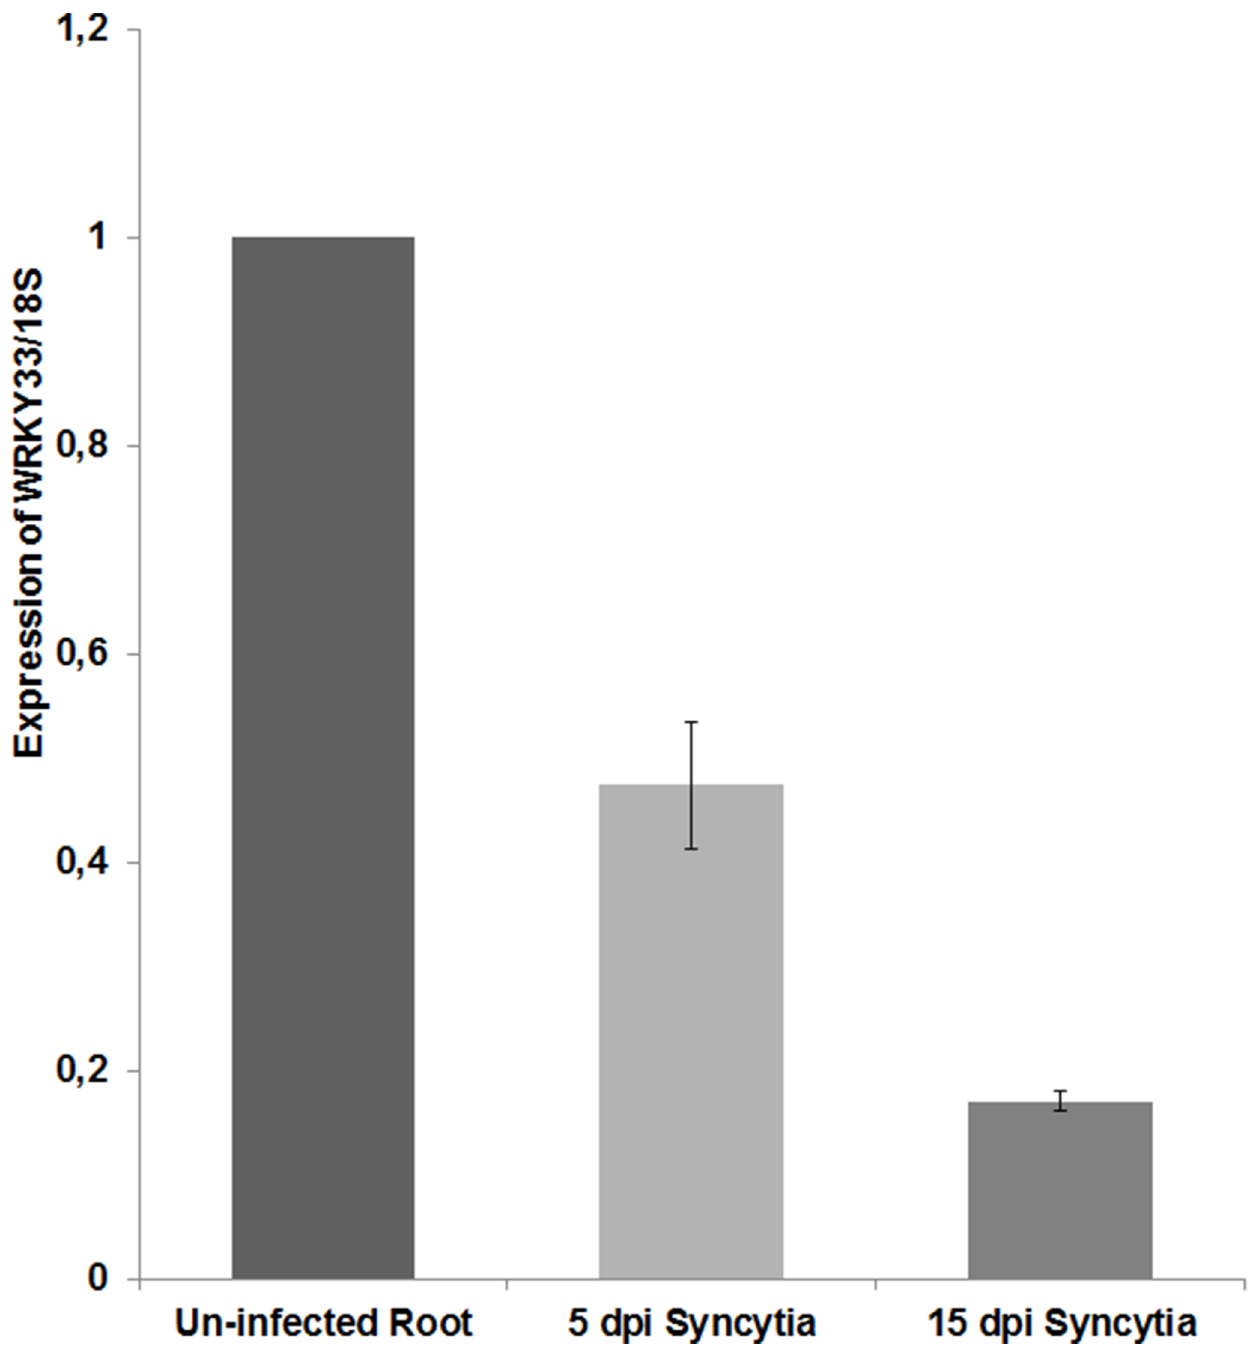
Figure 4. Expression of WRKY33 in response to nematode infection. Expression of WRKY33 in wild type plants was determined by qRT-PCR in 5 and 15 dpi syncytia and uninfected root segments (containing elongation zones without root tips from 15-d-old seedling). The data included three independent biological and three technical replicates. The WRKY33 expression values are relative to un-infected control roots and were normalized using 18S as a housekeeping gene. Values are means 6 SE, n=3. The bar shows standard error for the mean.